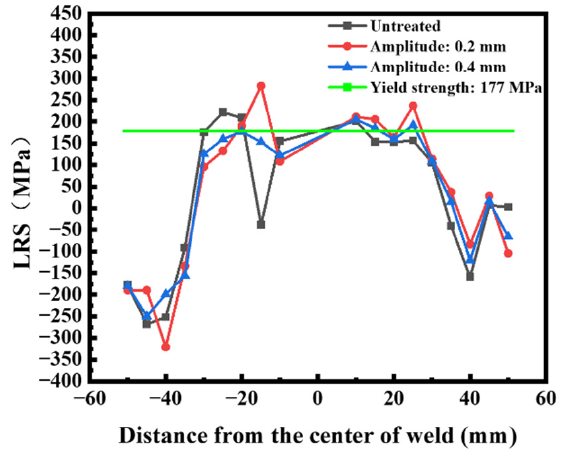
Figure 14. Residual stress distribution of single ultrasonic vibration treatment.